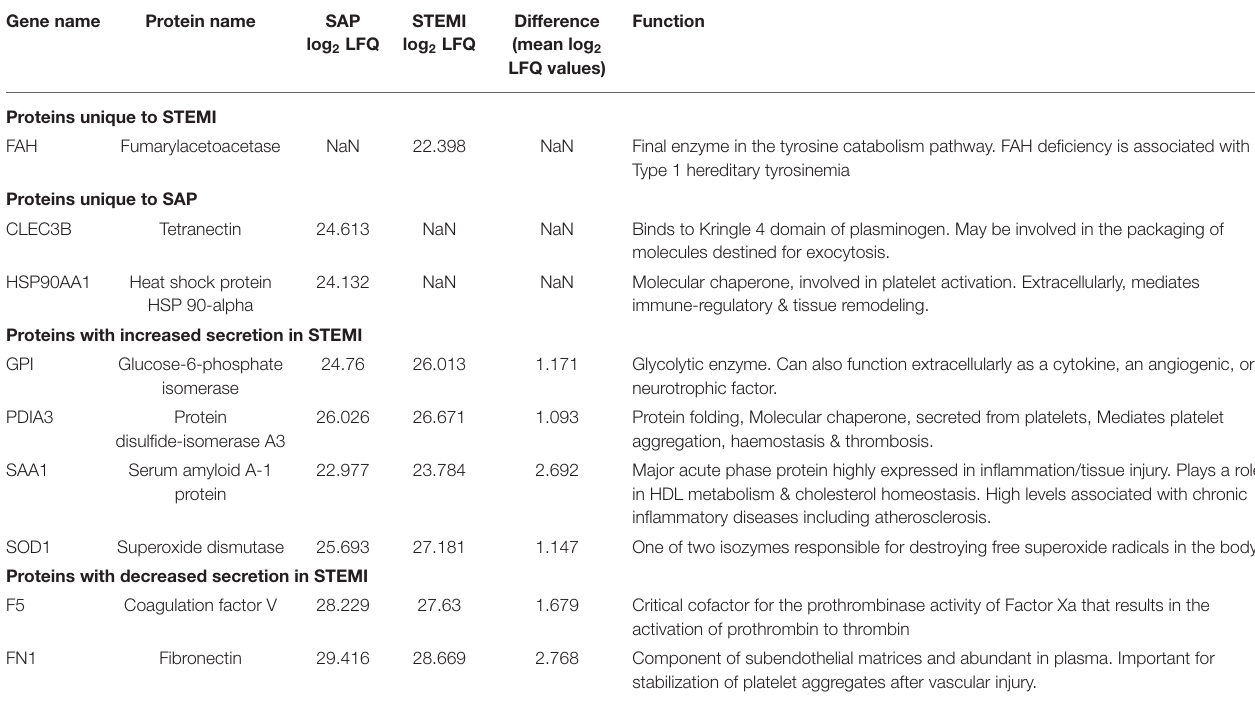
TABLE 2 | 9 PR proteins differentially released in STEMI vs.